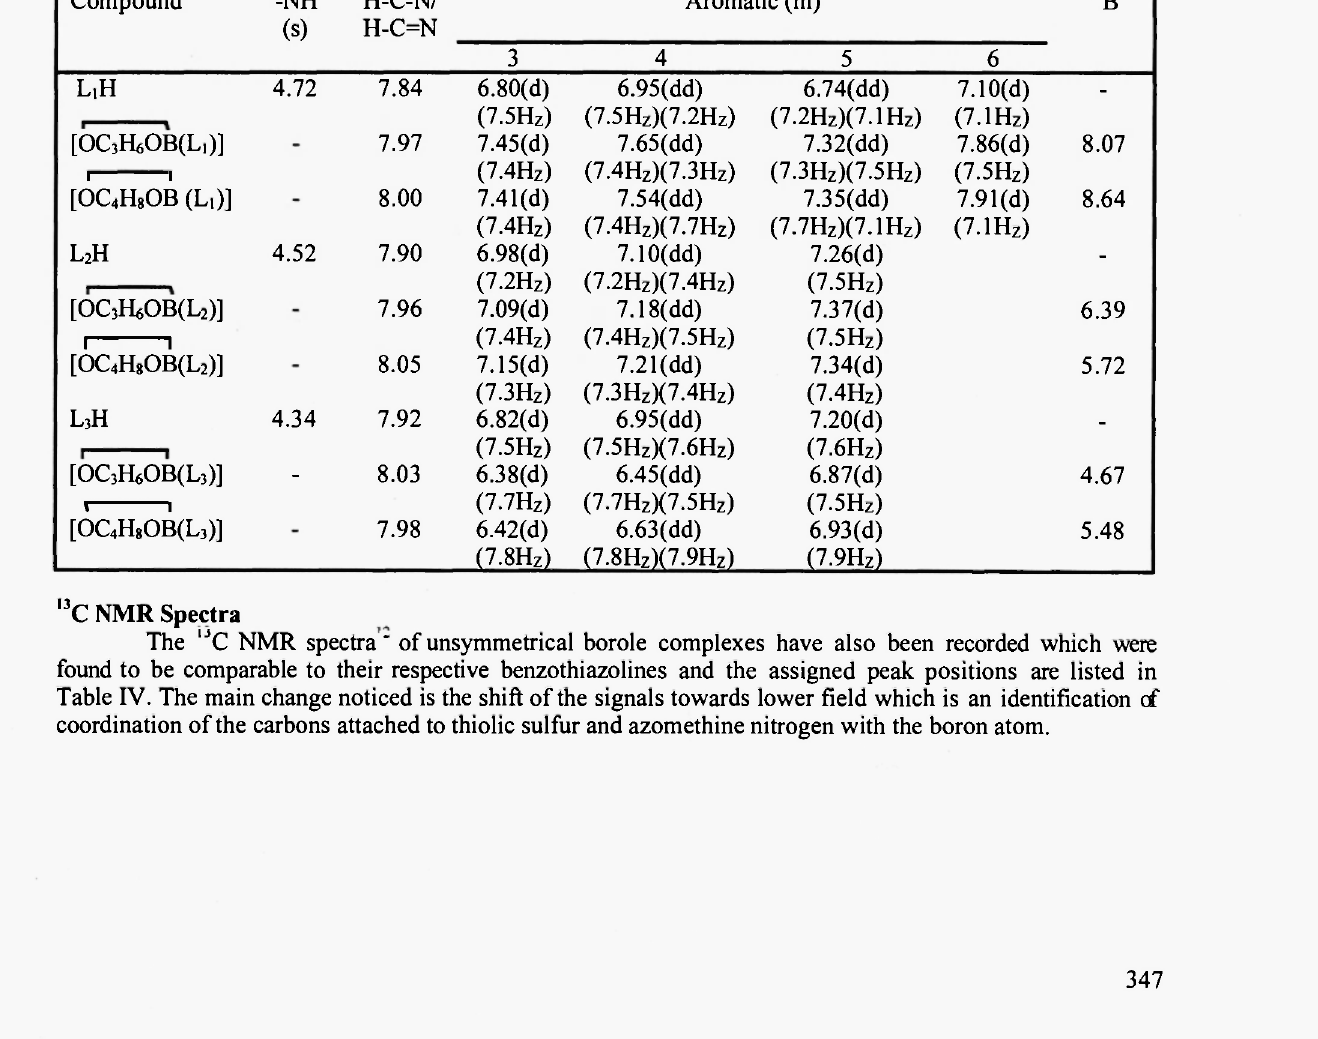
Table III: 'H NMR and n B NMR Spectral Data (5, ppm/JH z ) of Benzothiazolines and Their Complexes.